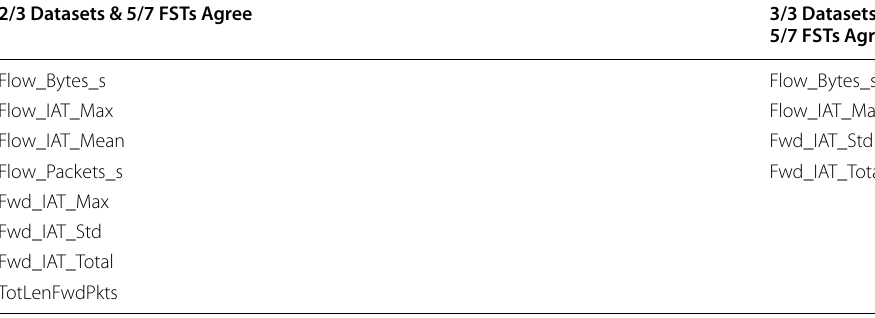
Table 7 2 Feature Popularity Lists where 6/7 FSTs Agree ( fst A 2/3 Datasets & 6/7 FSTs Agree